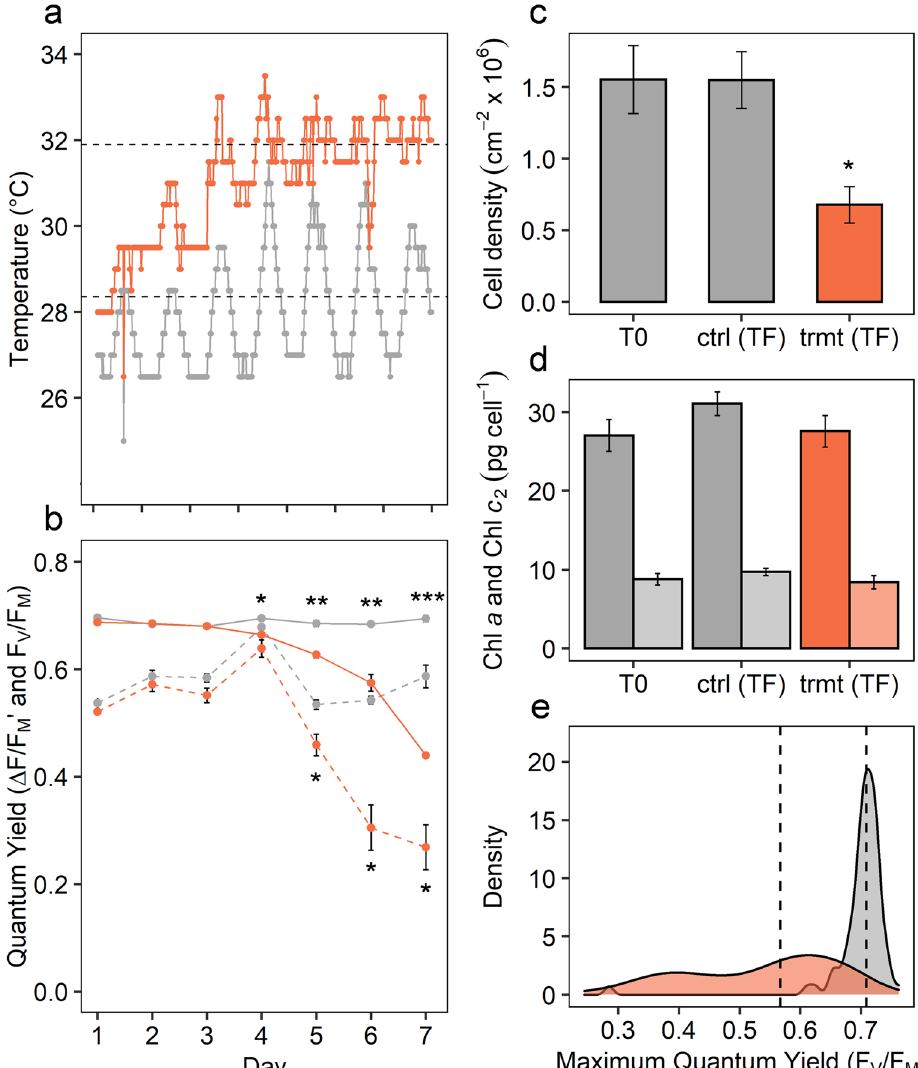
Figure 1. Temperature and general physiology of Acropora millepora and its symbionts under control (grey) and treatment (orange) conditions: ( a ) logged temperature in coral tanks over experimental period, ( b ) maximum (F V /F M ) and effective (ΔF/F M ′ ) quantum yield of PSII of coral colonies, ( c ) cell density at initial (T0), and final (TF) time points, ( d ) chlorophyll a and c 2 per cell at T0 and TF, ( e ) density plot of single-cell F V /F M measurements of symbionts extracted from Acropora millepora colonies at TF. Data ( b, c , d ) represent mean values ± standard error, and dotted lines ( a and e ) indicate mean. Asterisks denote significant differences between control and treatment at * < 0.05, ** < 0.01, *** <